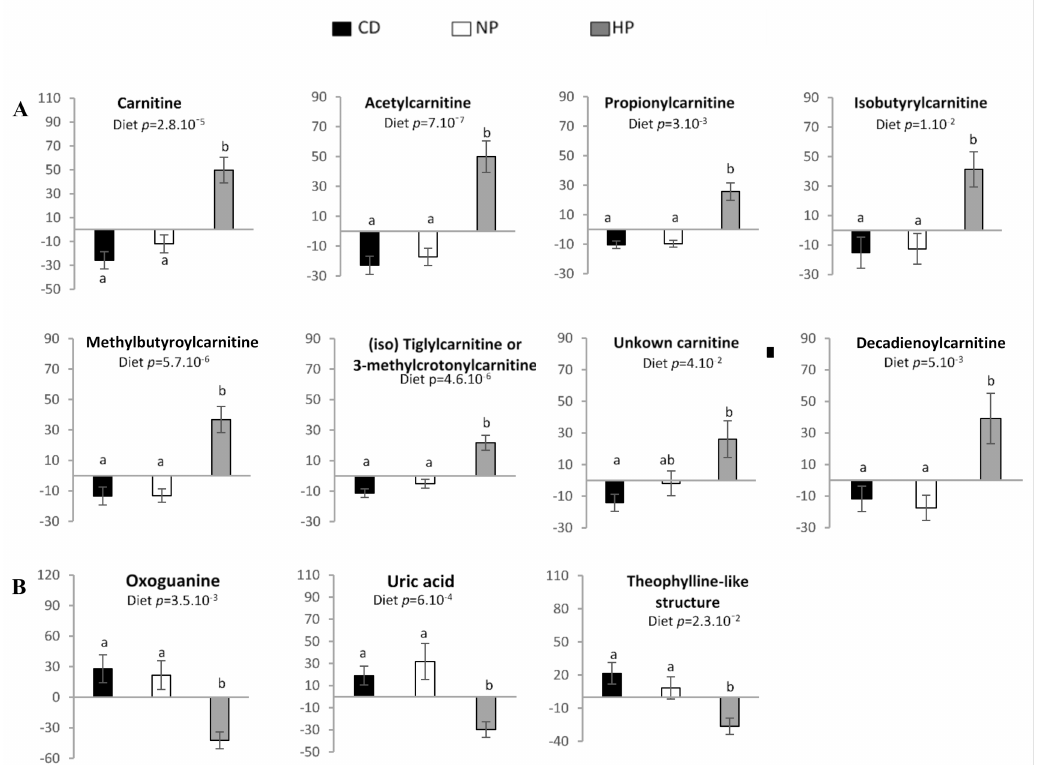
Figure 6. Relative signal intensity of features in urine associated with the HP high-fat hypercaloric diet: ( A ) Carnitine and short-chained acylcarnitines; ( B ) heterocyclic nitrogen-containing metabolites. Data are mean ± SEM. The p value is indicated on each graph, when the difference is significant, for the diet and period effect (ANOVA). When the diet effect is significant, different letters indicated significant differences between groups. CD—control diet; NP—normal protein, high-fat, hypercaloric diet; HP—high-protein, high-fat, hypercaloric